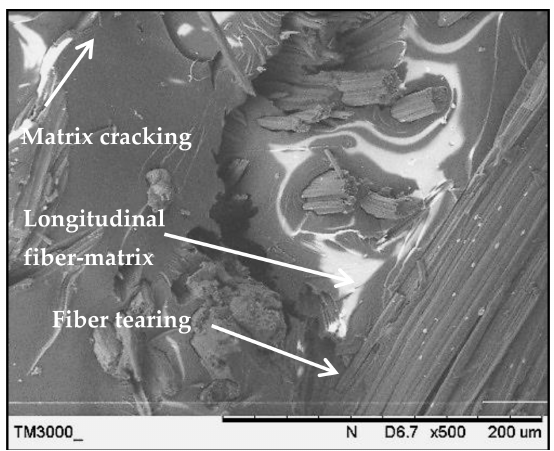
Figure 10. Scanning electron microscopy images of the treated PALF laminate (PPPP-treated) with ply orientation [0 ◦ , 90 ◦ ].